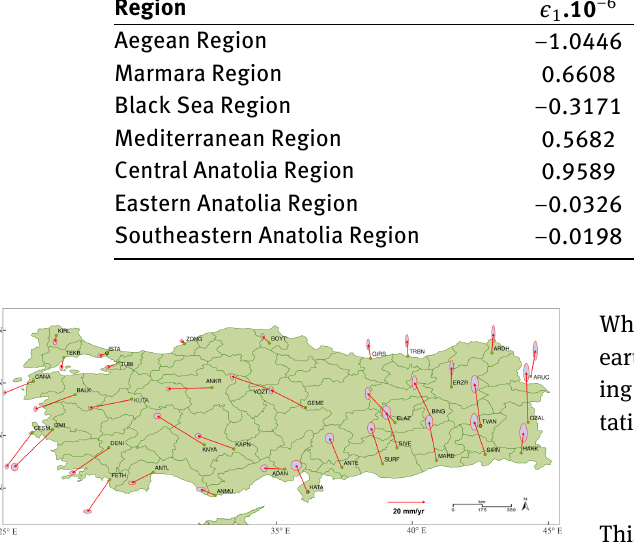
Figure 5: The observed velocity field and their uncertainties be- tween the years 2009 to 2017 for the GNSS sites